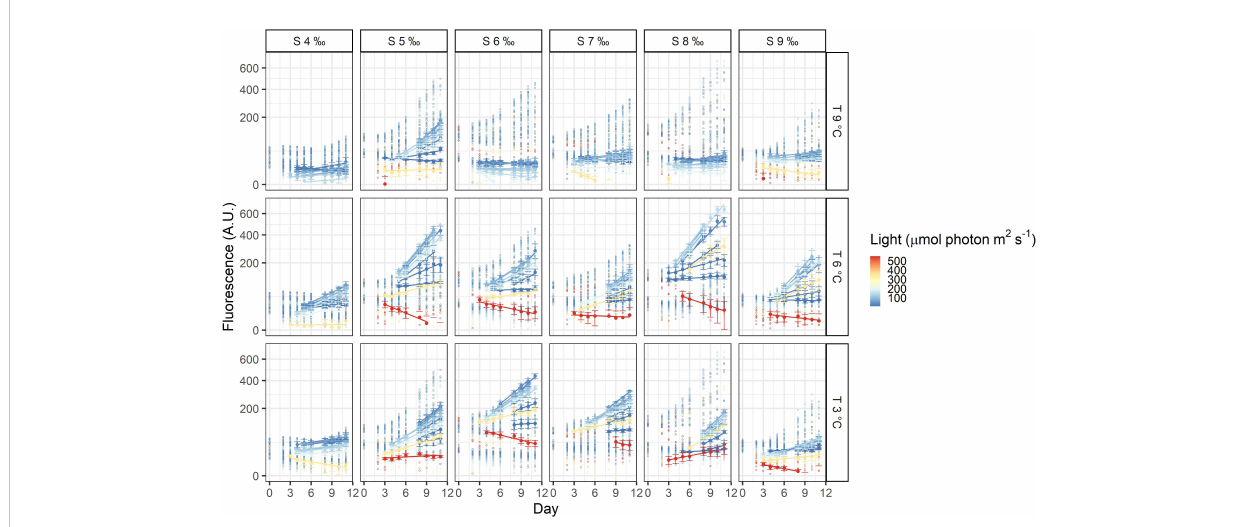
FIGURE 4 Fluorescence time series of Gymnodinium corollarium . Each circle is the observed fl uorescence of each well in each day. Daily means and standard deviations of the observations used to calculate the growth rates are depicted as full points with the error bars. The lines are linear regressions, included only for visualization